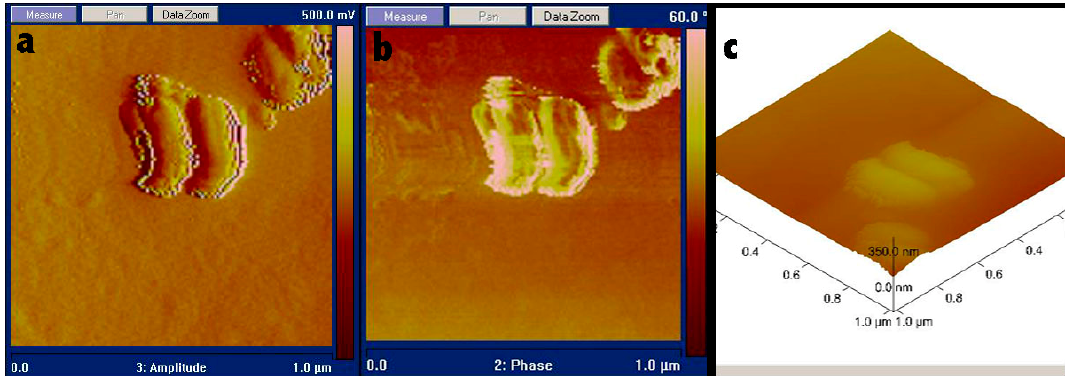
Figure 3. Morphology of PEI/SA hydrogel microcapsules revealed by atomic force microscope (AFM). ( a ) amplitude image; ( b ) phase image; ( c ) 3-D image.